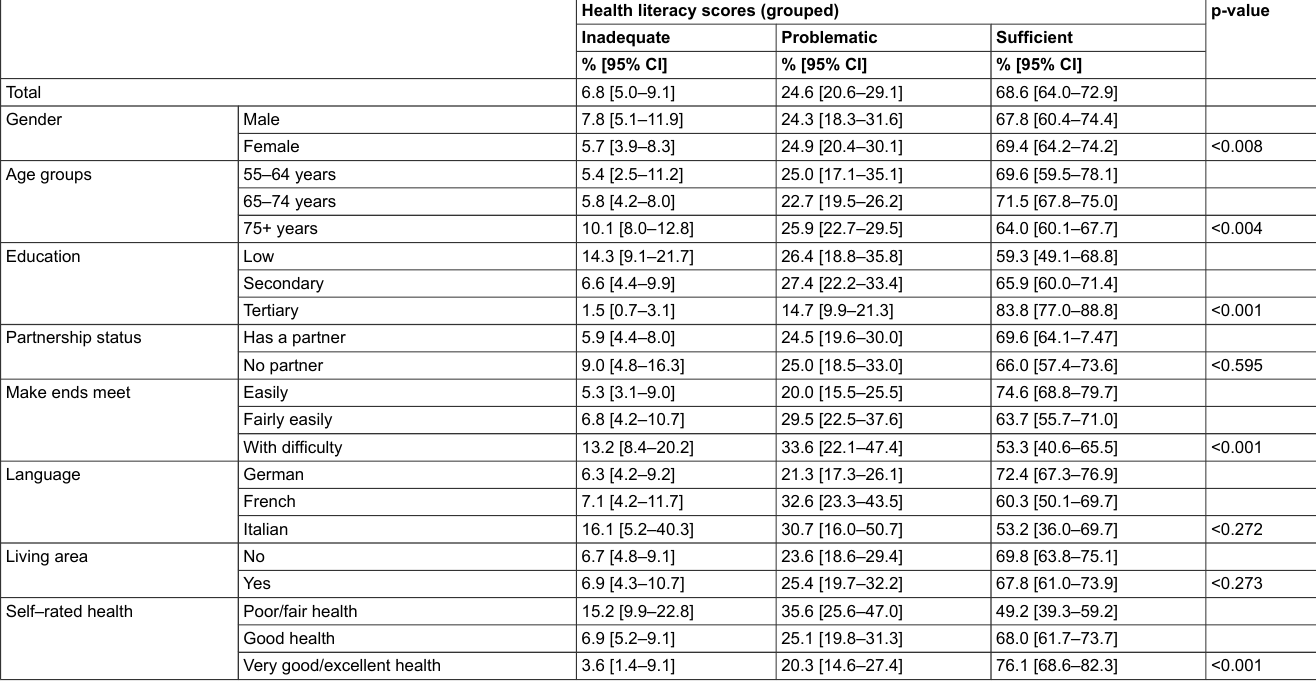
Table 2: Distribution of the three-category health literacy on the covariates, adults aged 58+, SHARE Switzerland, 2019/2020,n = 1,625